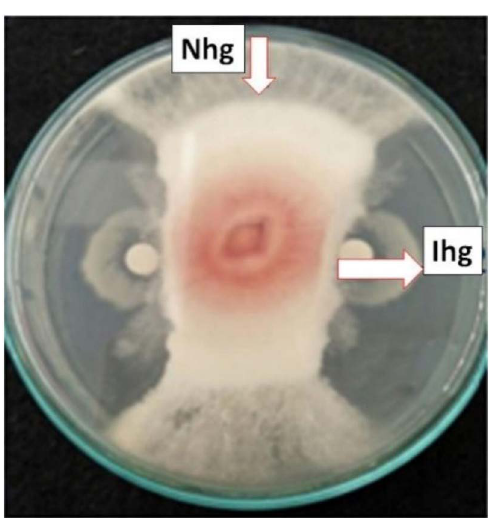
Fig. 2. Antagonistic assay of SP1 to F. oxysporum (Nhg: normal hyphae growth; Ihg: inhibited hyphal growth)